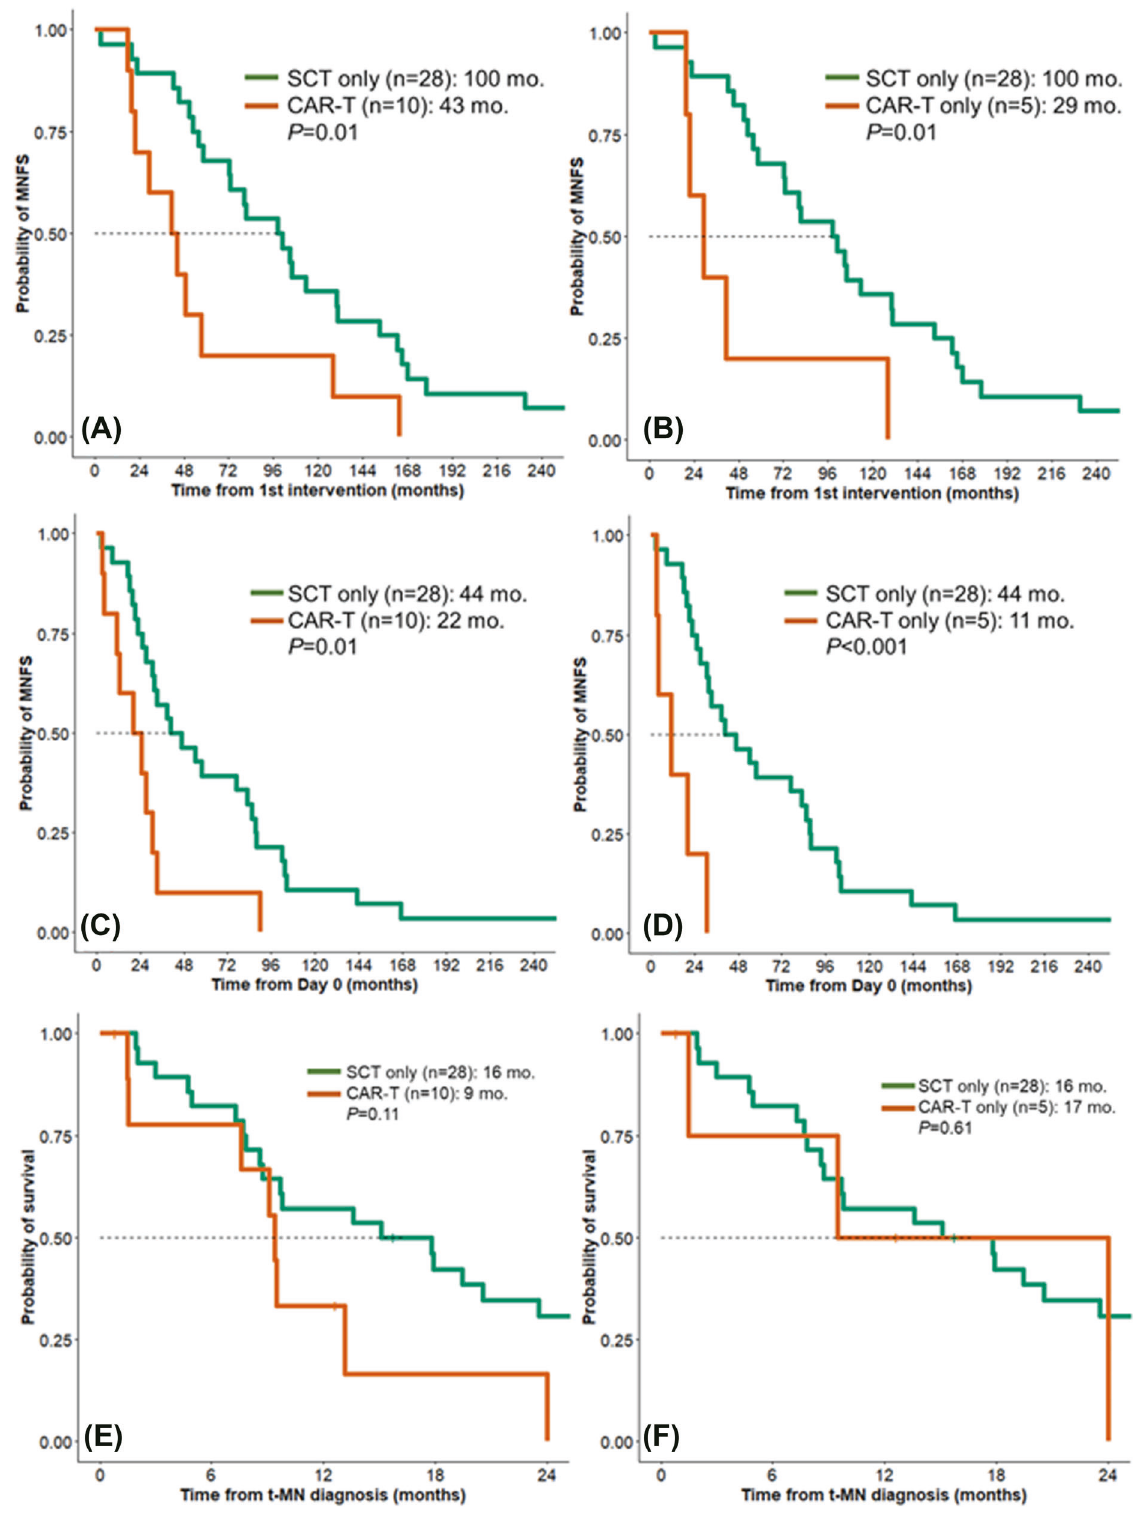
Fig. 2 The latency to develop therapy-related myeloid neoplasm is signi fi cantly shorter following chimeric antigen receptor (CAR)-T therapy compared to autologous stem cell transplant (SCT) in NHL. A Myeloid neoplasm-free survival (MNFS) from the fi rst intervention comparing patients who underwent SCT ( n = 28) with those who underwent CAR T cell therapy with or without prior SCT (CAR-T, n = 10). B MNFS from the fi rst intervention comparing patients who underwent SCT only ( n = 28) or CAR-T only ( n = 5). C MNFS from day 0 comparing patients who underwent SCT (n = 28) with those who underwent CAR-T with or without prior SCT ( n = 10). D MNFS from day 0 comparing patients who underwent SCT only ( n = 28) or CAR-T only ( n = 5). E Comparing OS from t-MN diagnosis in patients who underwent SCT ( n = 28) with those who underwent CAR-T with or without prior SCT ( n = 10), and F comparing OS from t-MN diagnosis in patients who underwent SCT only ( n = 28) or CAR-T only ( n = 5). Blood Cancer Journal (2022)